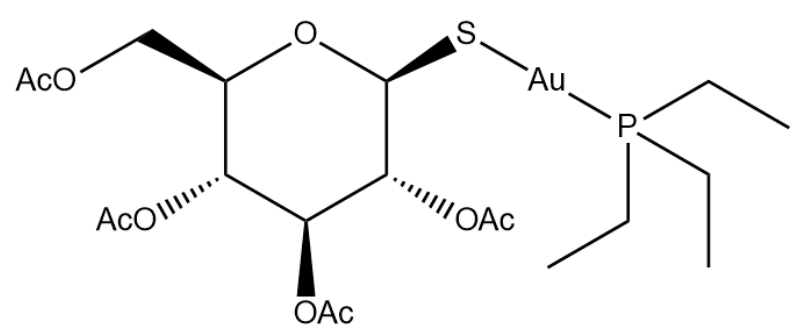
Figure 1. Auranofin structure.